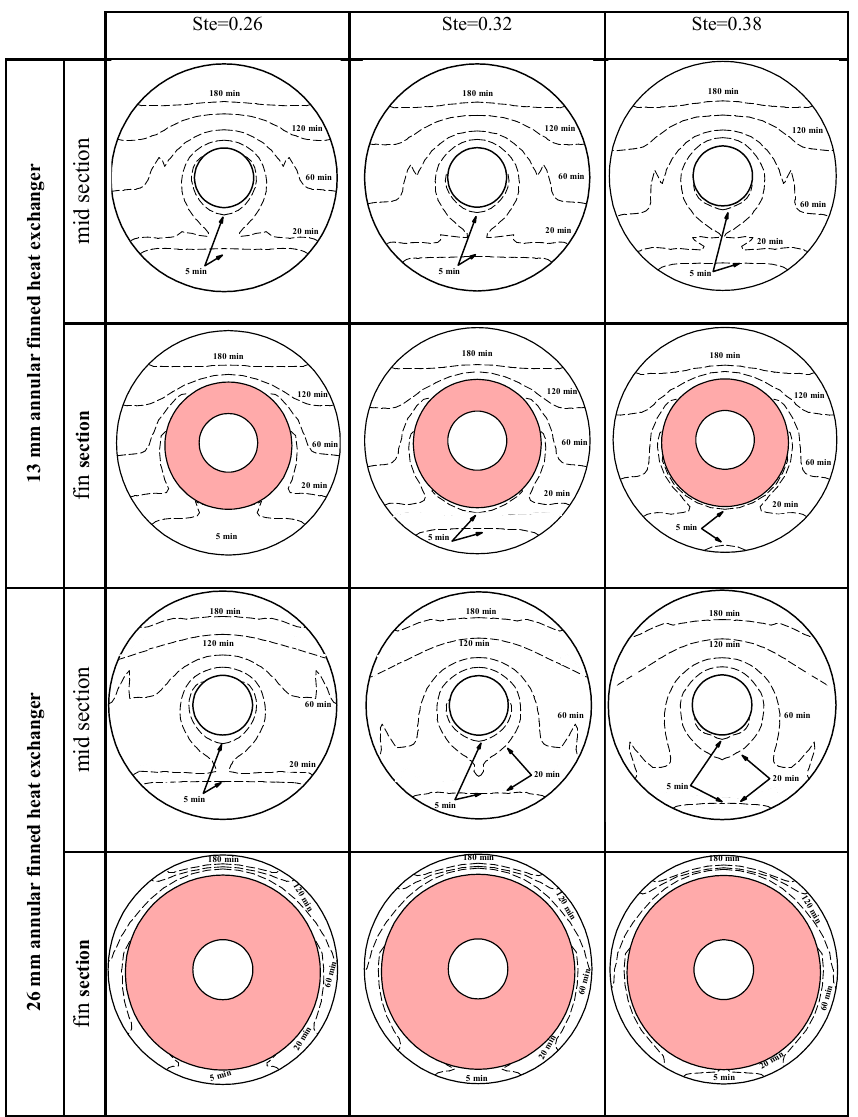
Figure 11. Numerical results of solid front in shell for different Stefan numbers in 13 and 26mm fins’ height at mid section and fin